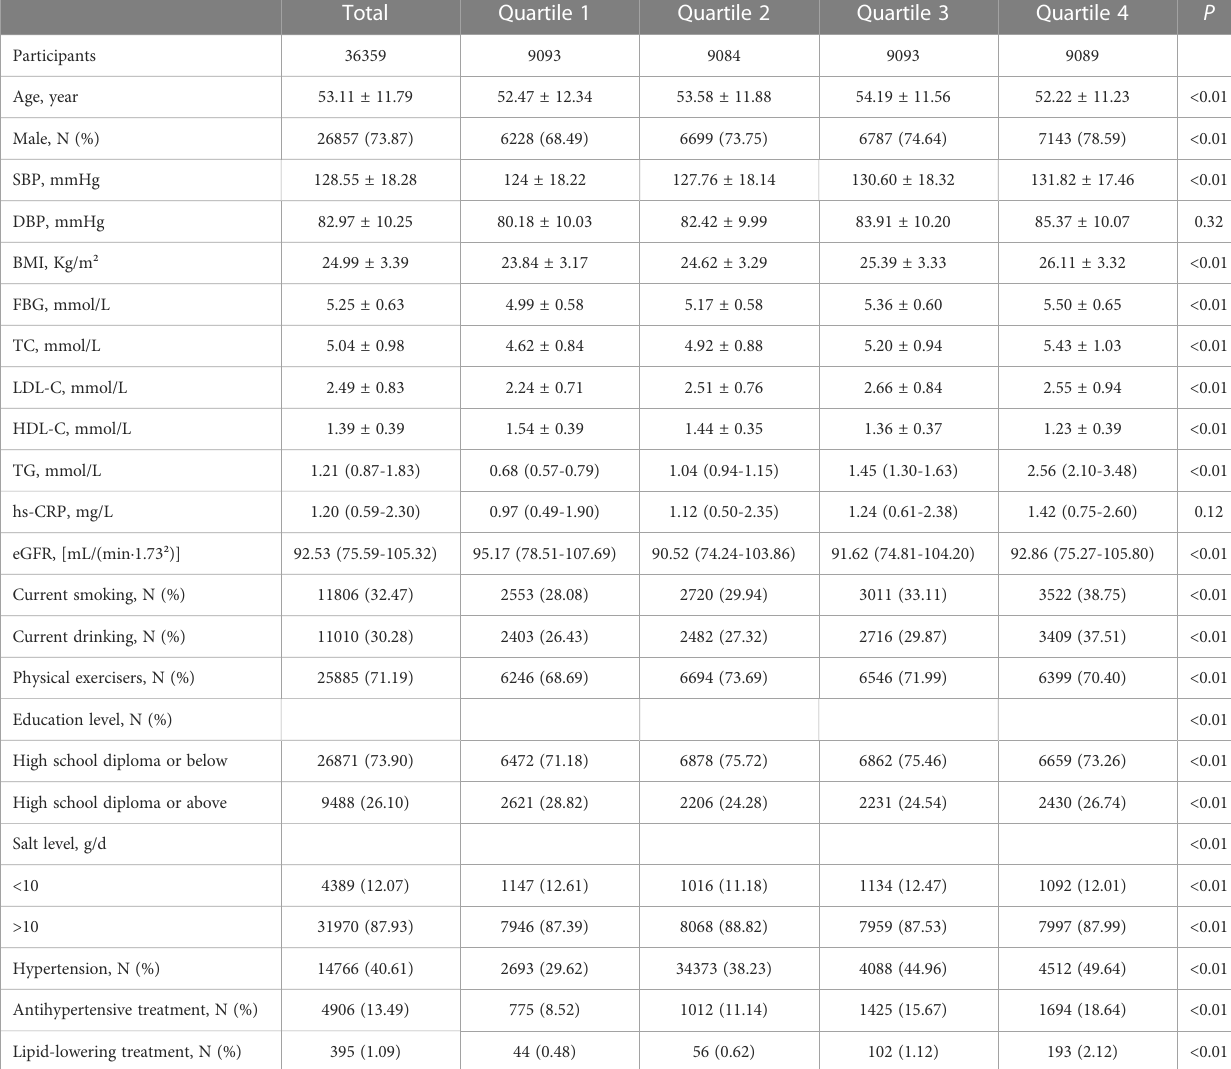
TABLE 1 Baseline characteristics according to quartiles of baseline TyG